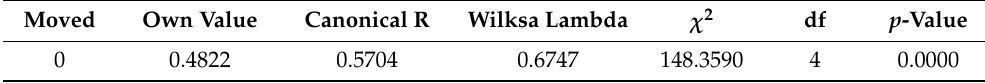
Table 8. Results of the canonical analysis.